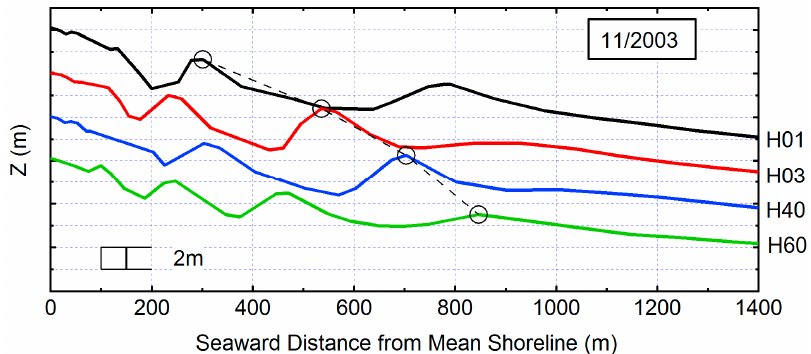
Figure 14. Alongshore comparison of the sandbar configuration.